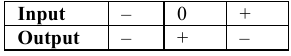
Table 1. Truth table for S 0